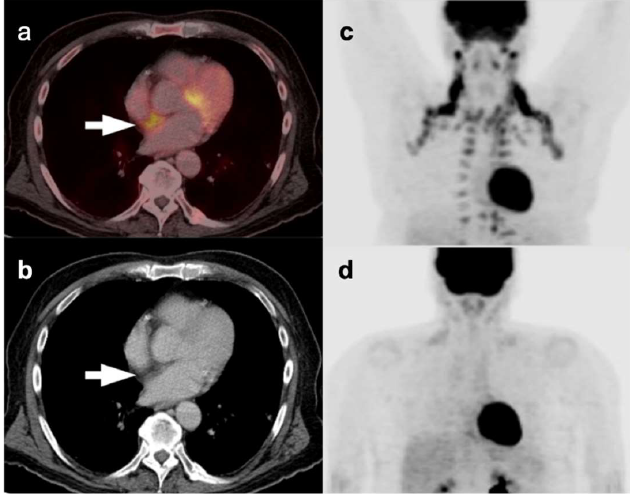
Figure 1. Variable appearance of hypermetabolic brown adipose tissue. ( a ) Axial FDG PET-CT and ( b ) CT images of the chest show typical appearance of lipomatous hypertrophy of the interatrial septum (LHIS) ( white arrows ); ( c ) MIP images of FDG PET scans of a patient who arrived cold for a PET-CT scan and showed hypermetabolic brown adipose tissue in the neck, axillas and paraspinous intercostal regions.; ( d ) A repeat study performed on the same patient as ( c ) with careful attention to maintaining a warm environment for the day prior to the repeat scan and during the interval from injection to imaging ( b , lower panel ) shows near complete resolution of hypermetabolic brown adipose